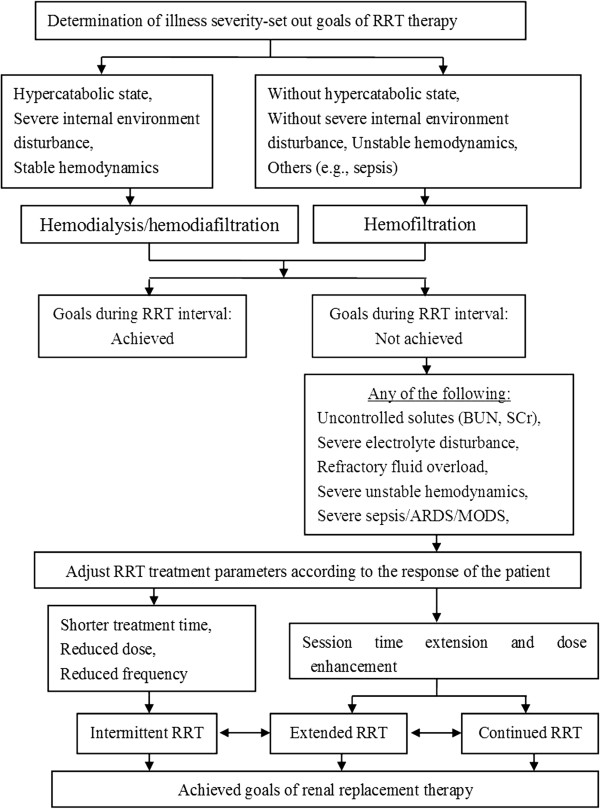
Scheme of the GDRRT algorithm.